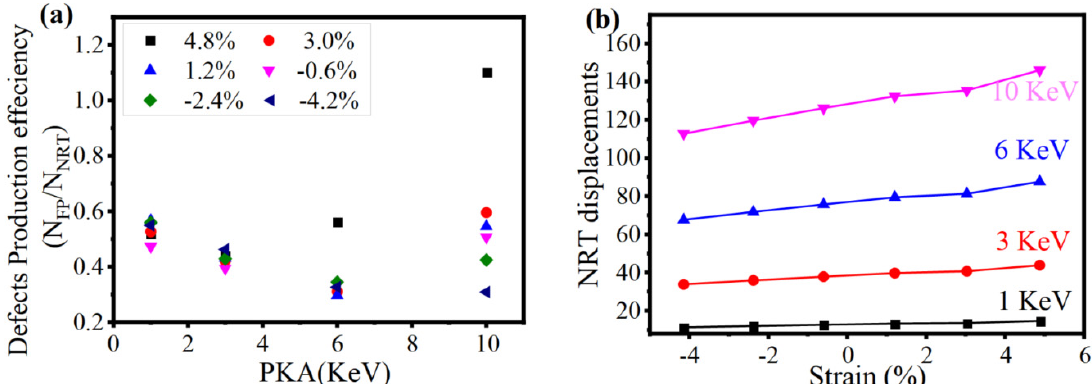
Figure 6. ( a ) The defect production efficiency, which is defined as the ratio between the molecular dynamics (MD) and the Norgett–Robinson–Torrens (NRT) result for defect calculations. ( b ) Number of surviving Frenkel pairs for various PKA energies versus applied and hydrostatic strain from NRT model applications V NRT = 0.8*E pka /2 E dj( ∆ V) [36].